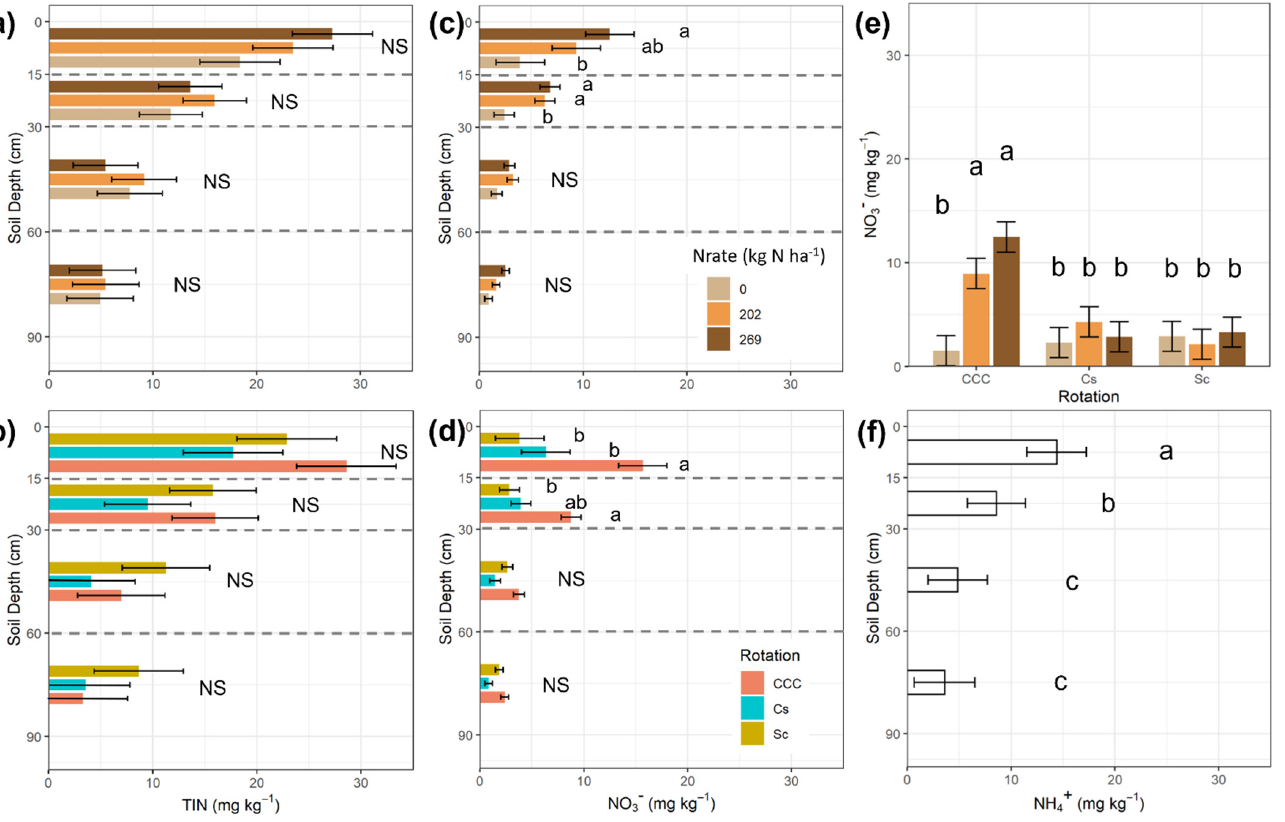
Figure 5. Averaged total inorganic N (TIN, mg kg − 1 ) determined at different depths of soils under different ( a ) N fertilization rates and different ( b ) crop rotations. Mean values of soil NO 3 − (mg kg − 1 ) separated by ( c ) N fertilization rate at each successive depth, and by ( d ) rotation at each depth. ( e ) The interaction effect of N fertilization rate and crop rotation on NO 3 − levels. ( f ) The mean NH 4+ values measured at each depth. In all cases, bars show the mean values and error bars represent the standard error of the treatment means. The placement of bars within each depth range (0–15, 15–30, 30–60, and 60–90; cm) do not signify differences in sampling depth. Crop rotations are continuous corn (CCC), and the corn-soybean rotation (CS) as corn Cs and soybean (Sc) phase, respectively. The N fertilization rates were 0, 202, and 269 (kg N ha − 1 ). Within each panel and a given depth, means followed by the same lowercase letters are not statistically different ( α = 0.05). Lack of statistically significant differences among treatment means within a given depth is indicated by “NS”.